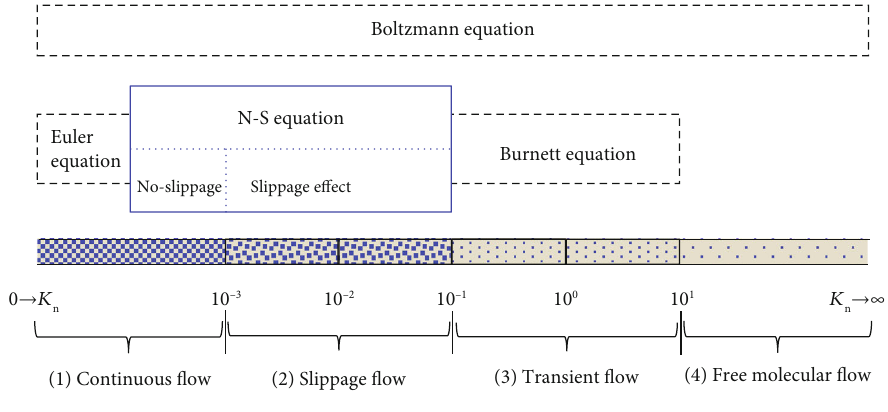
Figure 7: Knudsen number regimes [27].